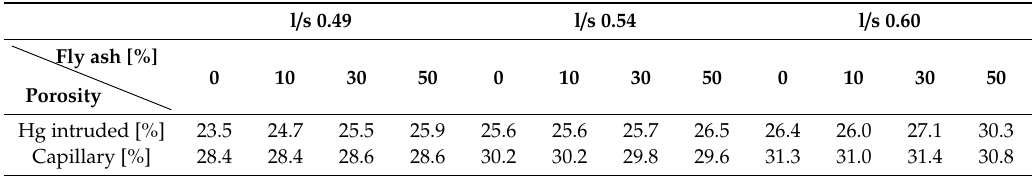
Table 4. Comparison of total Hg intruded porosity (MIP) and capillary porosity (water adsorption). l/s 0.49 l/s 0.54 l/s 0.60